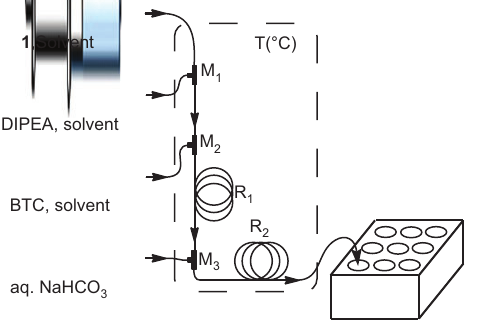
Figure 3 Schematic view of used set-up for carbamoyl chloride formation